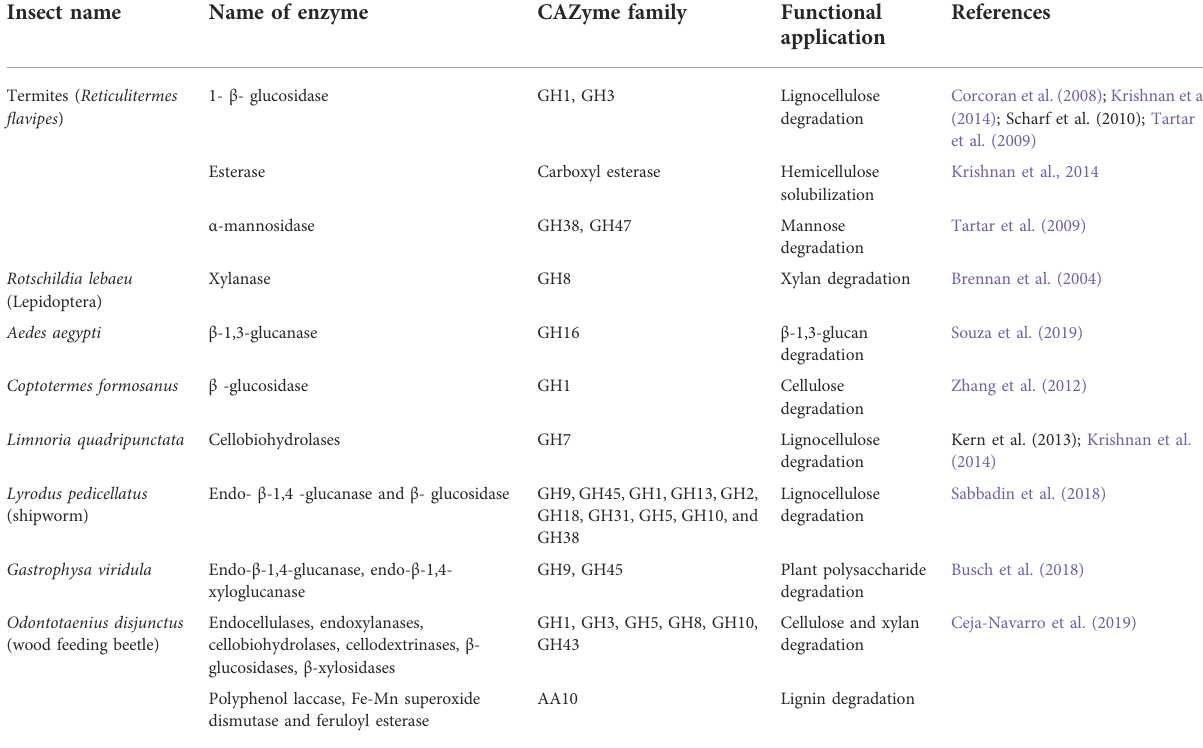
TABLE 2 List of CAZymes screened from different insect gut